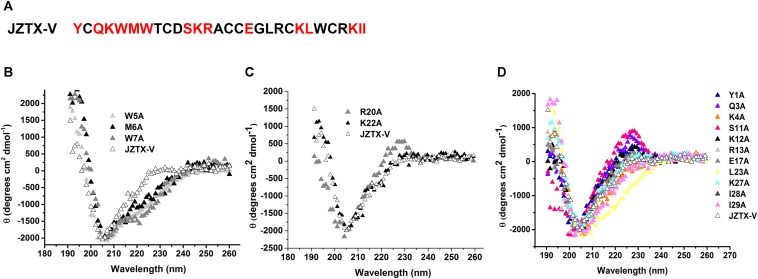
Sequence and CD spectra of JZTX-V. (A) Amino acid sequence of JZTX-V and its mutant residues are shaded. (B–D) Comparison of the CD spectrum of JZTX-V and mutants with the critical hydrophobic residues (B), and charged residues (C), and other mutants (D).